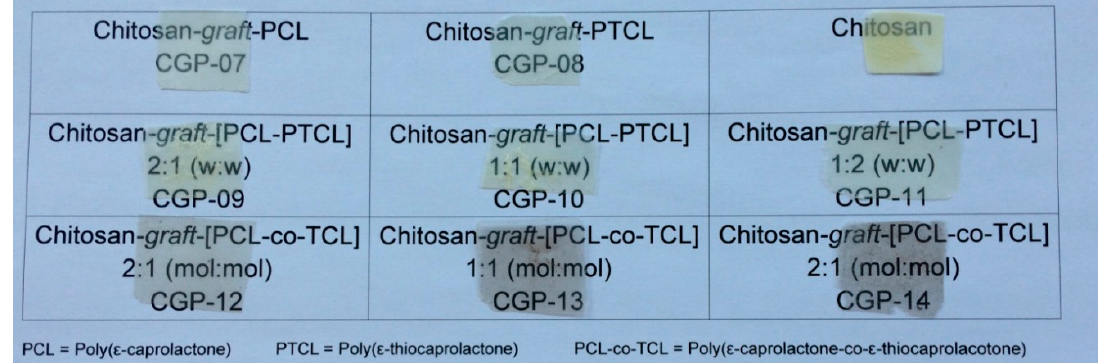
Figure 8. Films obtained from chitosan and chitosan-grafted (co)polymers.